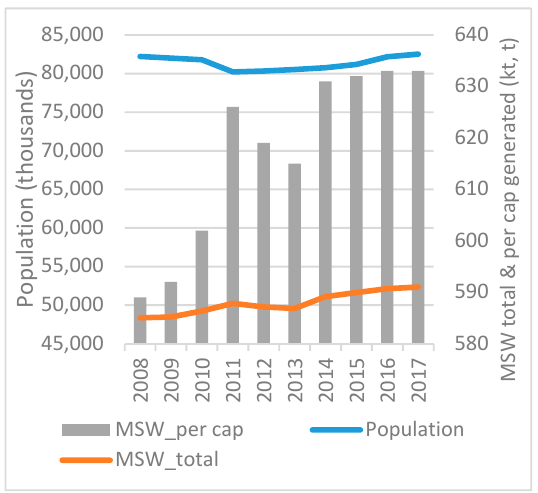
Figure 9. Population and MSW production in Germany 2008–2017 (EUROSTAT 2019a, 2019c). Soc. Sci. 2019 , 8 , x FOR PEER REVIEW